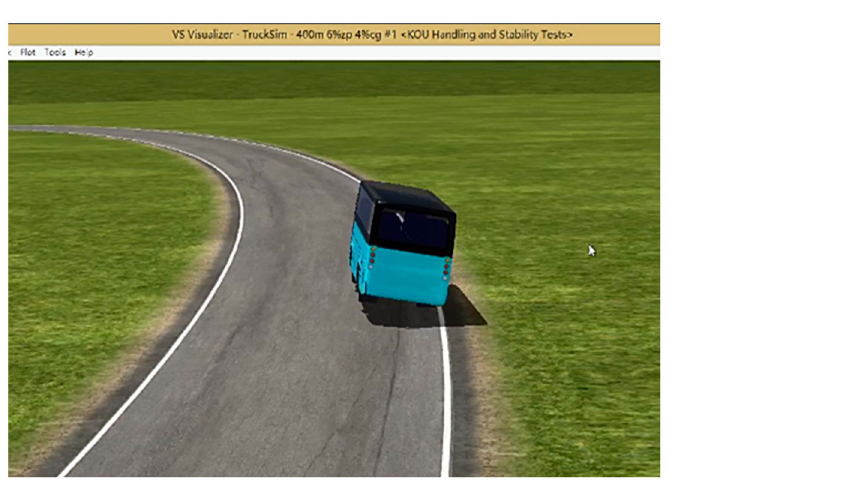
Fig 6. Critical state of large bus sideslip.